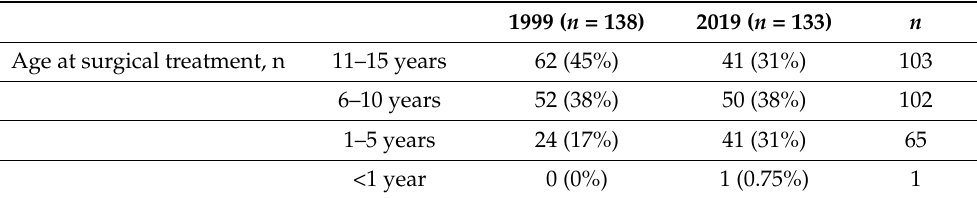
Table 3. Age of patients at surgical